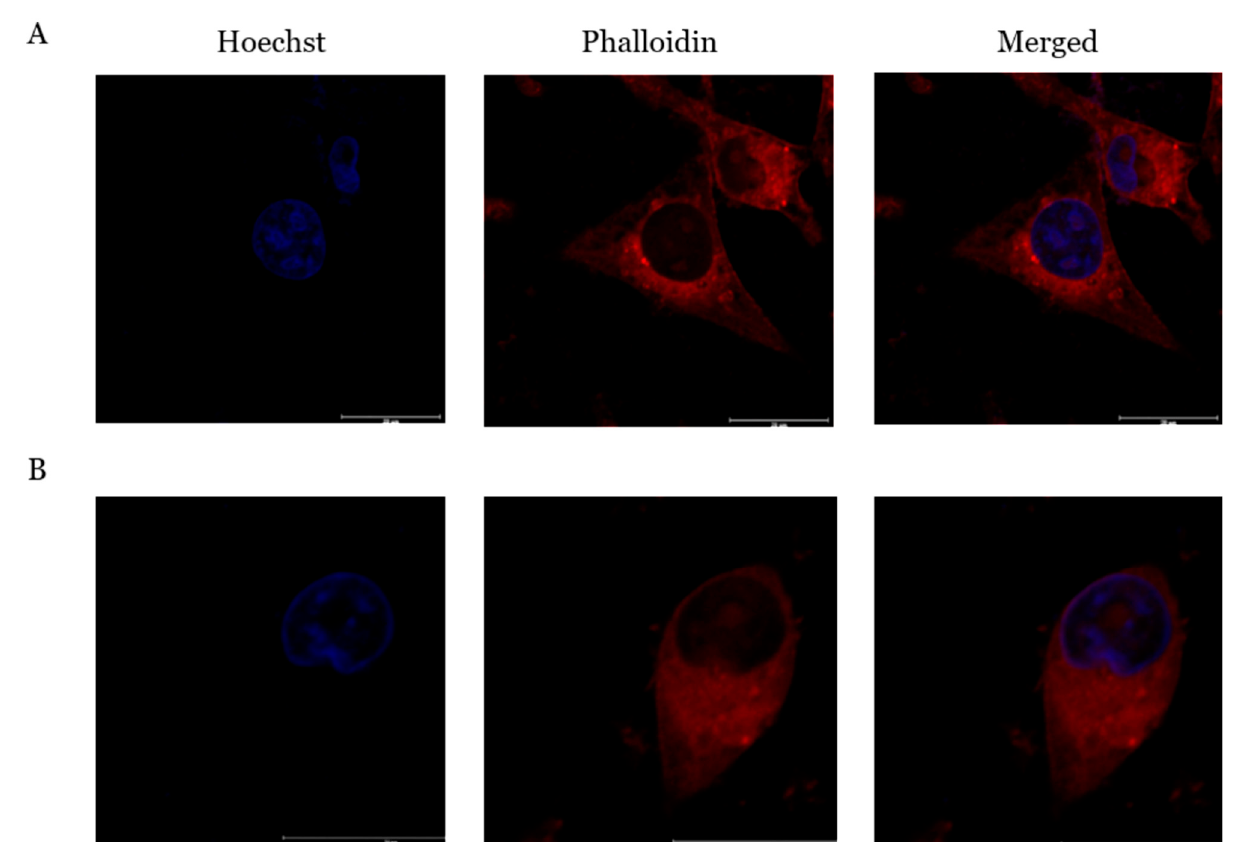
Figure 7. Phalloidin staining for cytoskeleton: ( A ) Untreated MDA MB231 cells stained with rhodamine- Phalloidin showing rigid cytoskeleton. ( B ) PcOSM treated MDAMB-231 cells showing cytoskeletal changes.